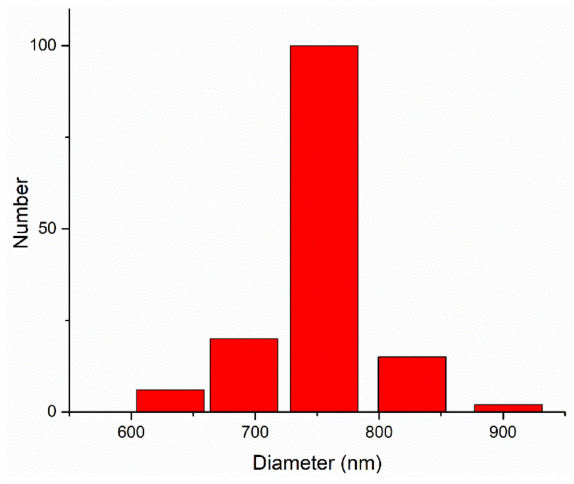
Figure 4. Numerical particle size distribution of the mixture. Table 1. Data of the particle size distribution of the mixture.